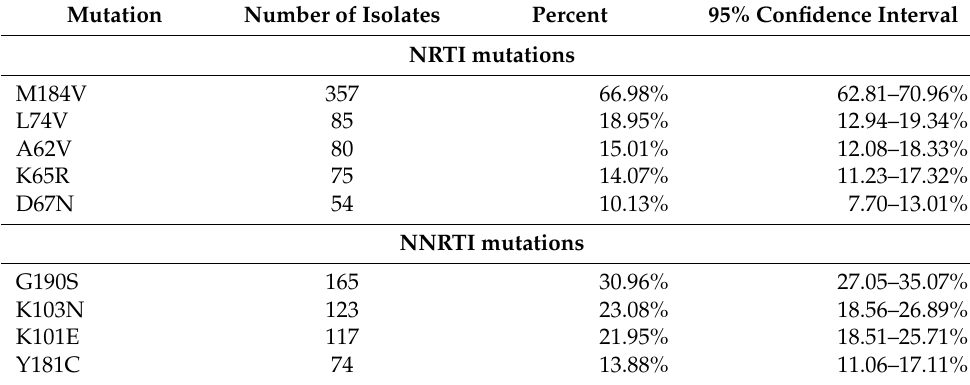
Table 2. Most common drug resistance